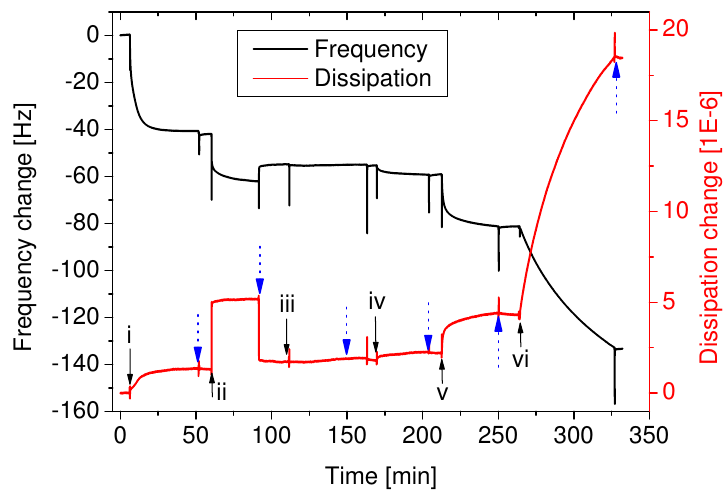
rinse (marked with dotted arrows), are an artefact from the temporarily enhanced pressure in the flowcell and are completely